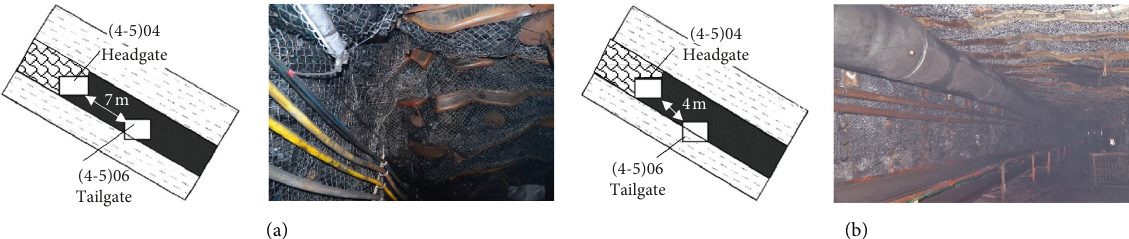
Figure 9: Field photos of gob-side entry for various sectional coal pillar widths: (a) sectional coal pillar width 7 m; (b) sectional coal pillar width 4